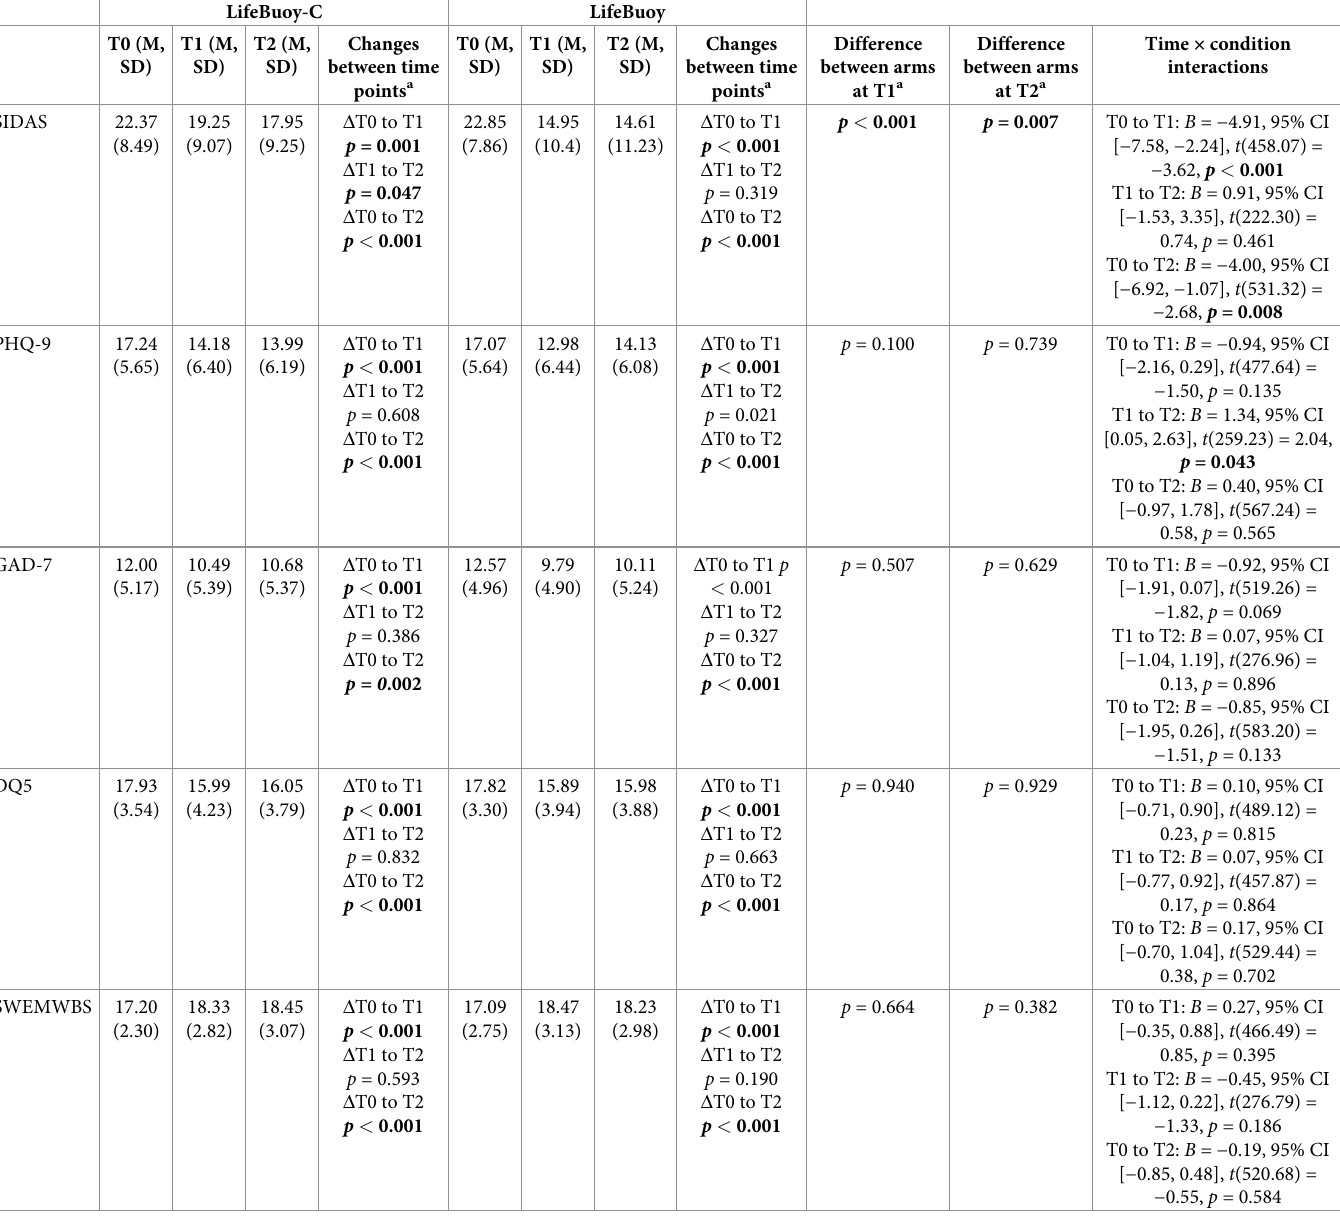
Table 2. Mean scores, tests of time × condition interactions, and comparisons between time points and conditions. LifeBuoy-C